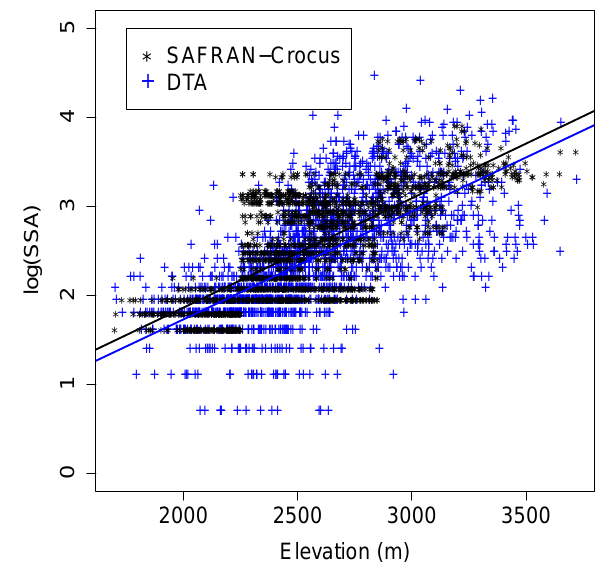
Fig. 11. Repartition of log(SSA) with regards to elevation for SAFRAN-Crocus (in black) and DTA (in blue), with linear regressions, on 2009-04-22.